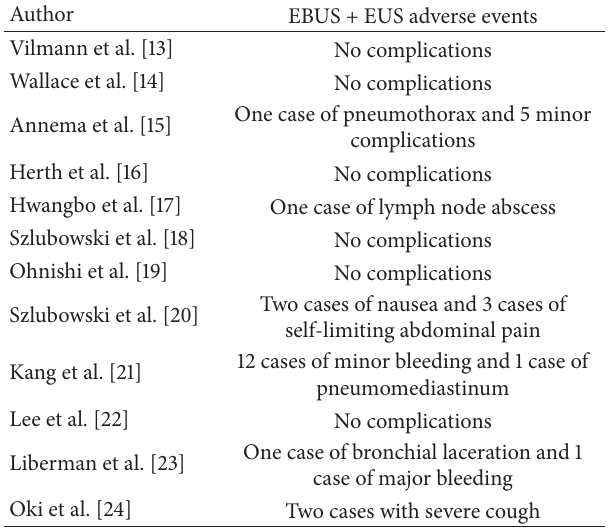
Table 2: EBUS + EUS adverse events reported in primary studies.